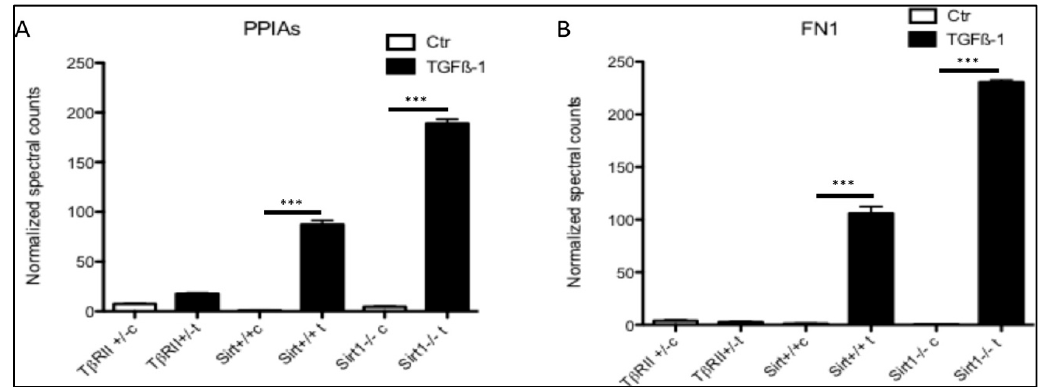
Figure 3. Quantitative analysis of PPIA secretion in Sirt − / − and T β RII +/ − mice primary cell secretomes from our former published studies [4,32,33]. Primary endothelial cells were isolated from Sirt +/+ , Sirt − / − , T β RII +/+ , and T β RII +/ − mice kidneys ( n = 3 for each mouse genotype) and treated with TGFß1. Supernatant from treated cells and controls were collected and the secretomes were analyzed using mass spectrometry. ( A ) The quantitative analyses showed that PPIA was highly secreted in Sirt +/+ , Sirt − / − , and T β RII +/+ upon TGF β 1 treatment, but not in T β RII +/ − . Moreover, the secretion level in the Sirt − / − primary cells was two times higher than in treated Sirt +/+ cells. ( B ) Quantitative presentation of the secretion level of FN1 in Sirt − / − and T β RII +/ − primary cells upon TGF β 1 treatment. The normalized spectral counts were used for protein level quantification (*** p < 0.001).